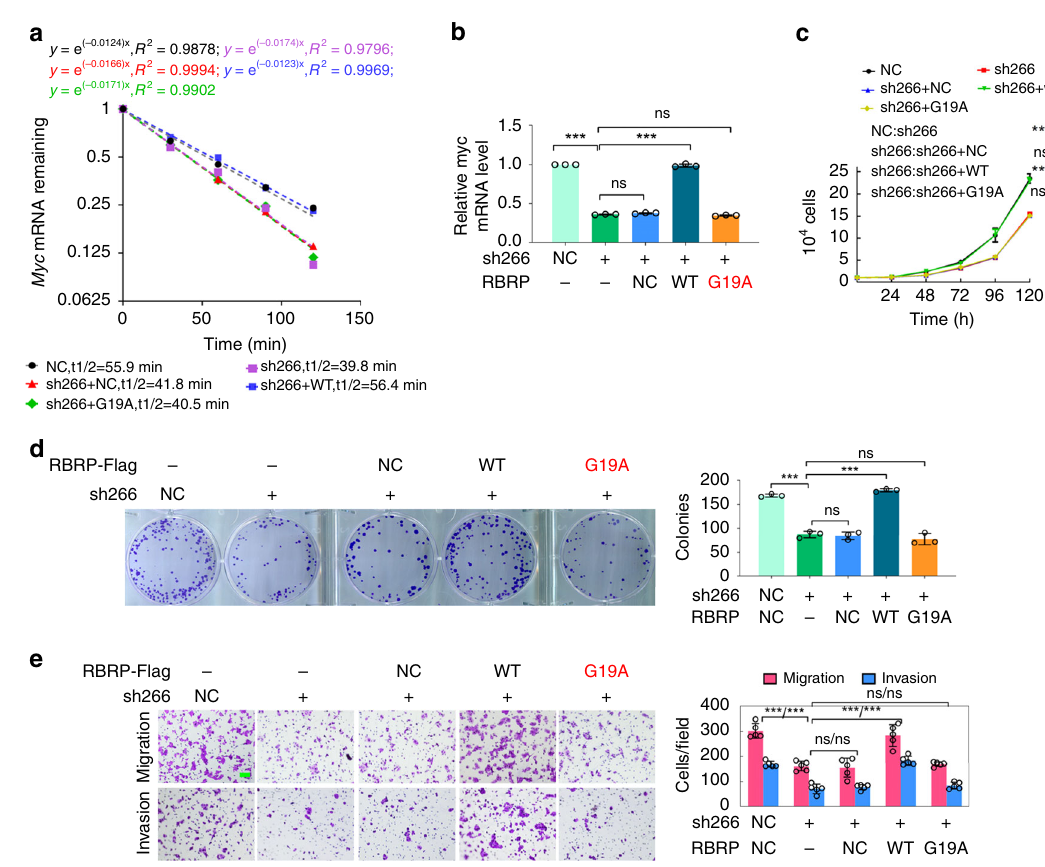
Fig. 7 RBRP regulates c-Myc mRNA stability and tumorigenesis by binding to IGF2BP1. a – e The WT or G19A-mutated RBRP constructs, which were resistant to anti- LINC00266-1 shRNA, were transfected into HCT-116 cells with stable knockdown of LINC00266-1 expression by an anti- LINC00266-1 shRNA lentivirus targeting the 3 ′ -UTR of the LINC00266-1 ORF (sh266); the half-life ( a ) ( n = an experiment) and level ( b ) ( n = 3 independent experiments) of c-Myc mRNA were detected, along with cell proliferation ( c ) ( n = 3 independent experiments), colony formation ( d ) ( n = 3 independent experiments), and migration and invasion ( e ) ( n = 5 independent experiments). Scale bar: 50 μ m. The G19A mutation of RBRP, which did not bind to the m 6 A reader IGF2BP1, abolished the stimulatory effects of RBRP on c-Myc stability and expression and cancer cell proliferation, colony formation, migration, and invasion. Two-tailed unpaired Student ’ s t -test unless speci fi cally stated, two-way ANOVA in c . The data are represented as the means ± SD. * p < 0.05, ** p < 0.01, or *** p < 0.001, ns indicates no signi fi cance. Source data are provided as a Source Data fi